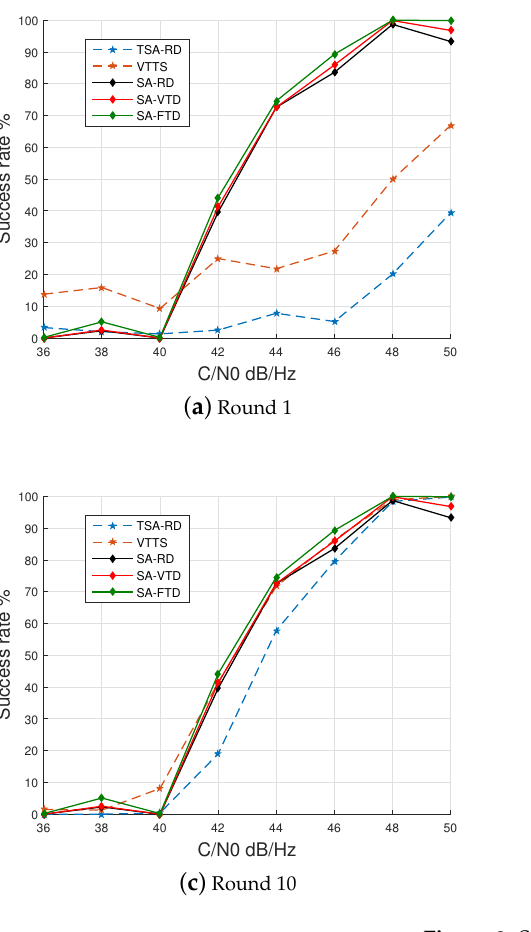
Figure 8. Sucess